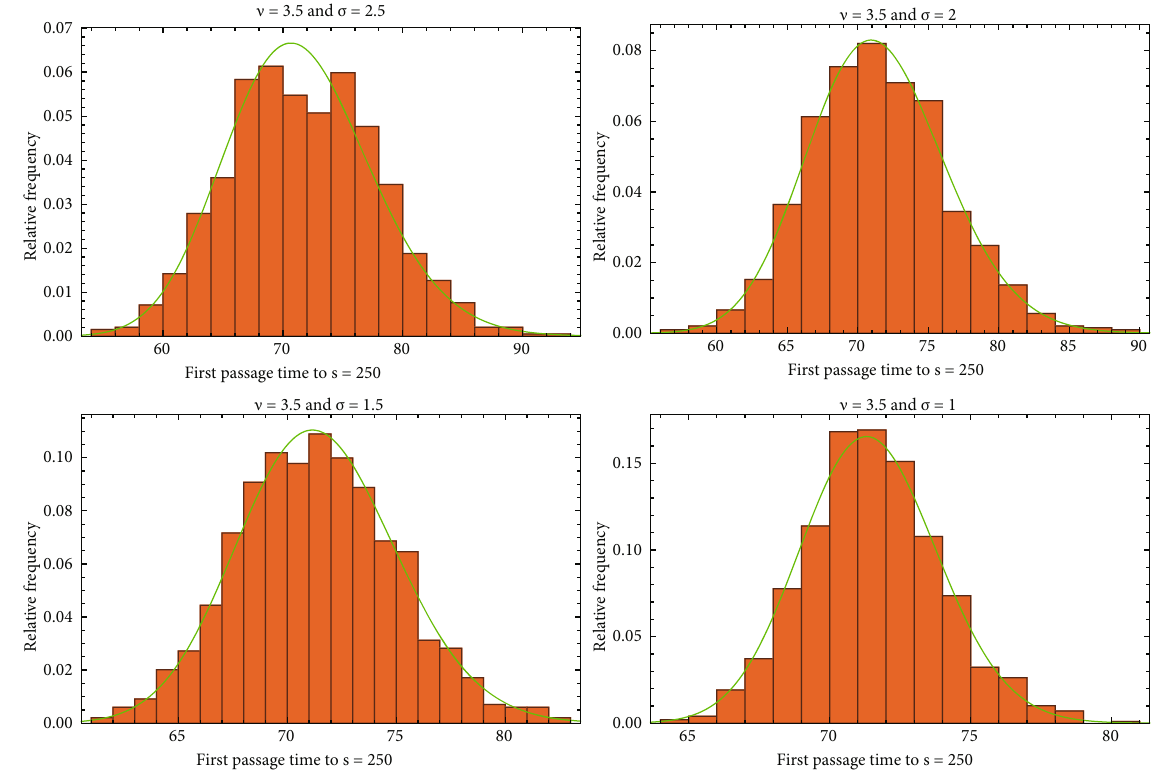
Figure 4: Histograms of fi rst passage times and theoretical